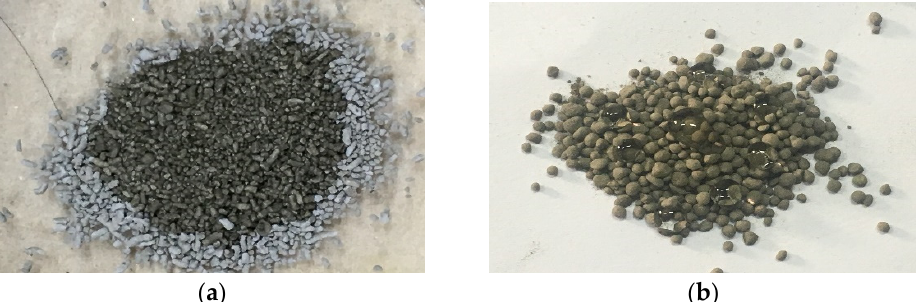
Figure 3. State with or without surface coating of core material: ( a ) no surface coating, ( b ) after surface coating.